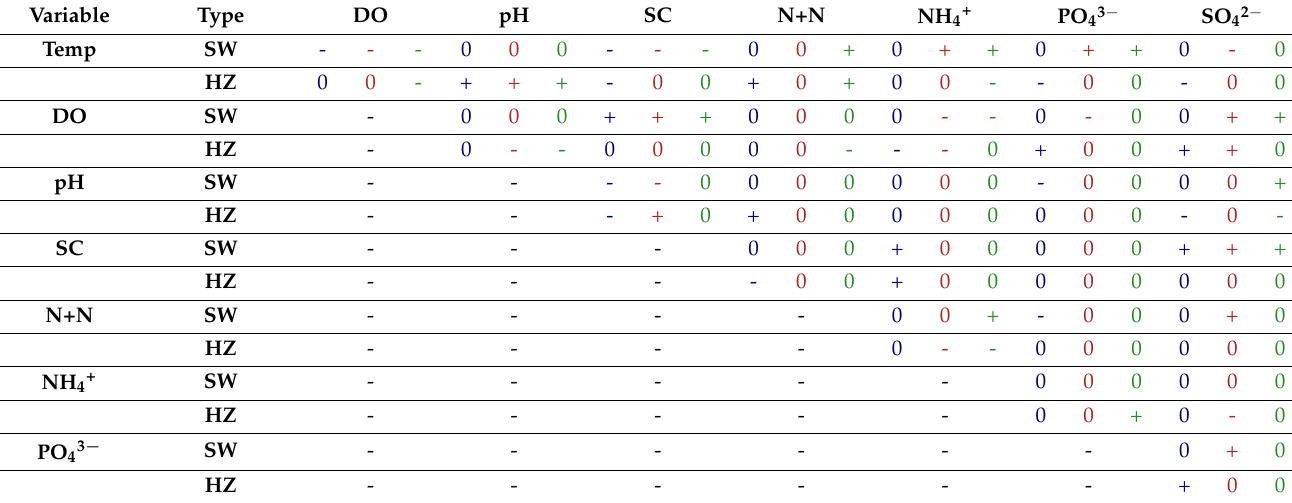
Table 3. Spearman correlation information for GR (blue) , SB (red) , and TC (green) for temperature (Temp), dissolved oxygen (DO), pH, specific conductance (SC), nutrients and sulfate. Measurements from both surface water (SW) and subsurface water, collected from the hyporheic zone (HZ), are included. All correlations shown as positive (+) or negative ( − ) are statistically significant ( p < 0.05). Non-significant correlations are shown as “0”. See Table S5 for r and p values. Variable